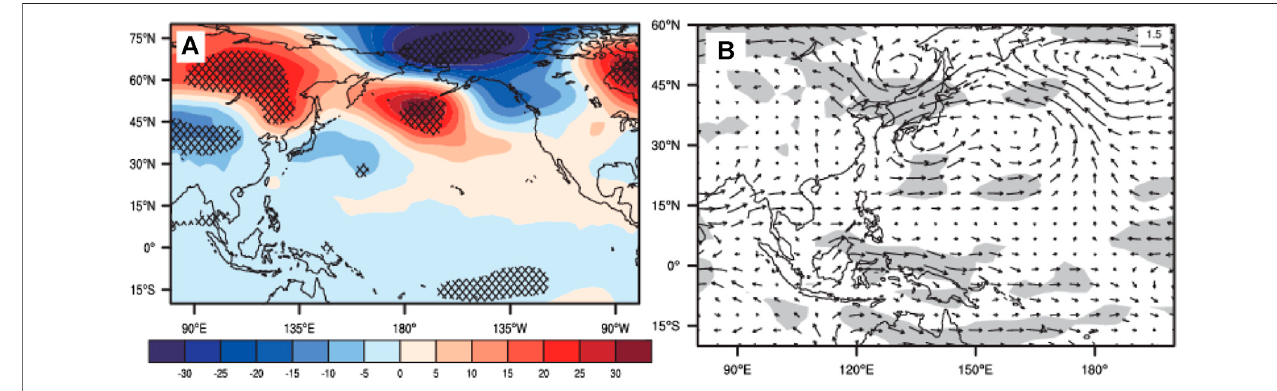
FIGURE 15 | Ensemble-mean differences of (A) 500 hPa geopotential height (gpm), (B) 850 hPa wind (m/s) anomalies in July – September between West Wind Dirft_W and West Wind Dirft_C. Dotted areas and shaded areas indicate the differences that are signi fi cant at the 90% con fi dence level.